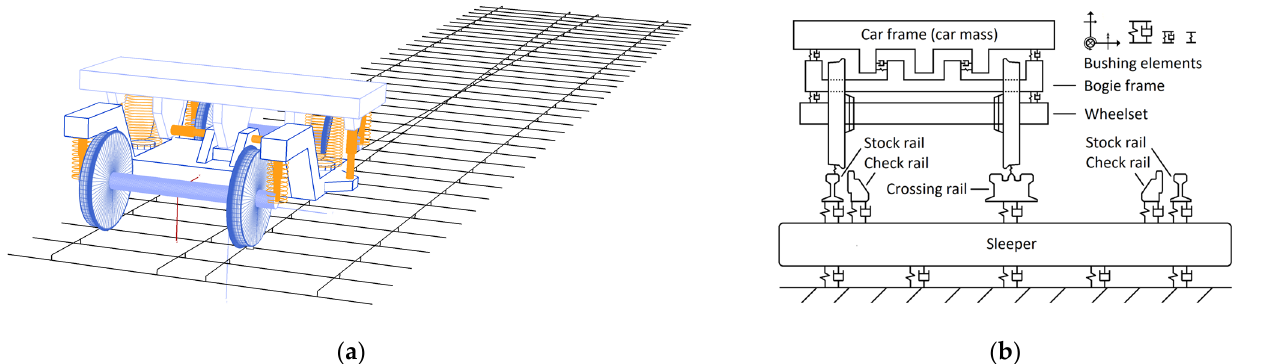
Figure 7. ( a ) MBS model of vehicle–track system, and ( b ) 2D representation of vehicle–track system during a passage through the crossing panel.